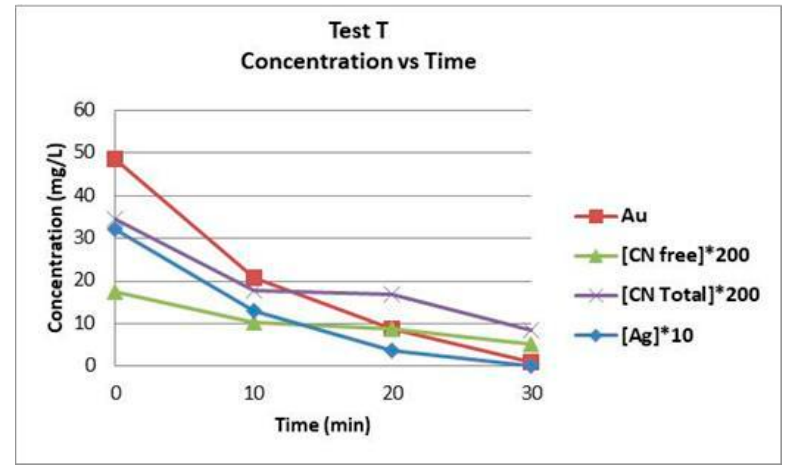
Figure 6. Graph of concentration versus t, in test T.